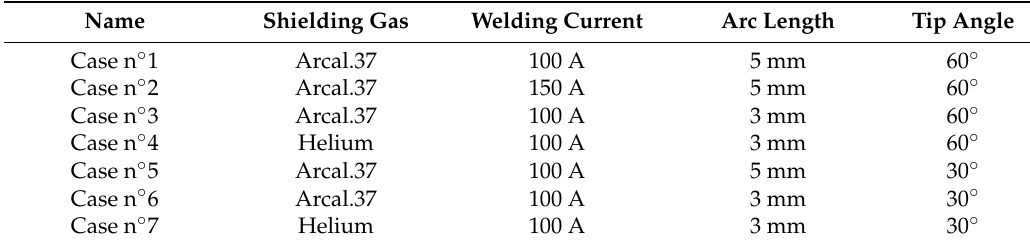
Table 1. Details of welding cases.